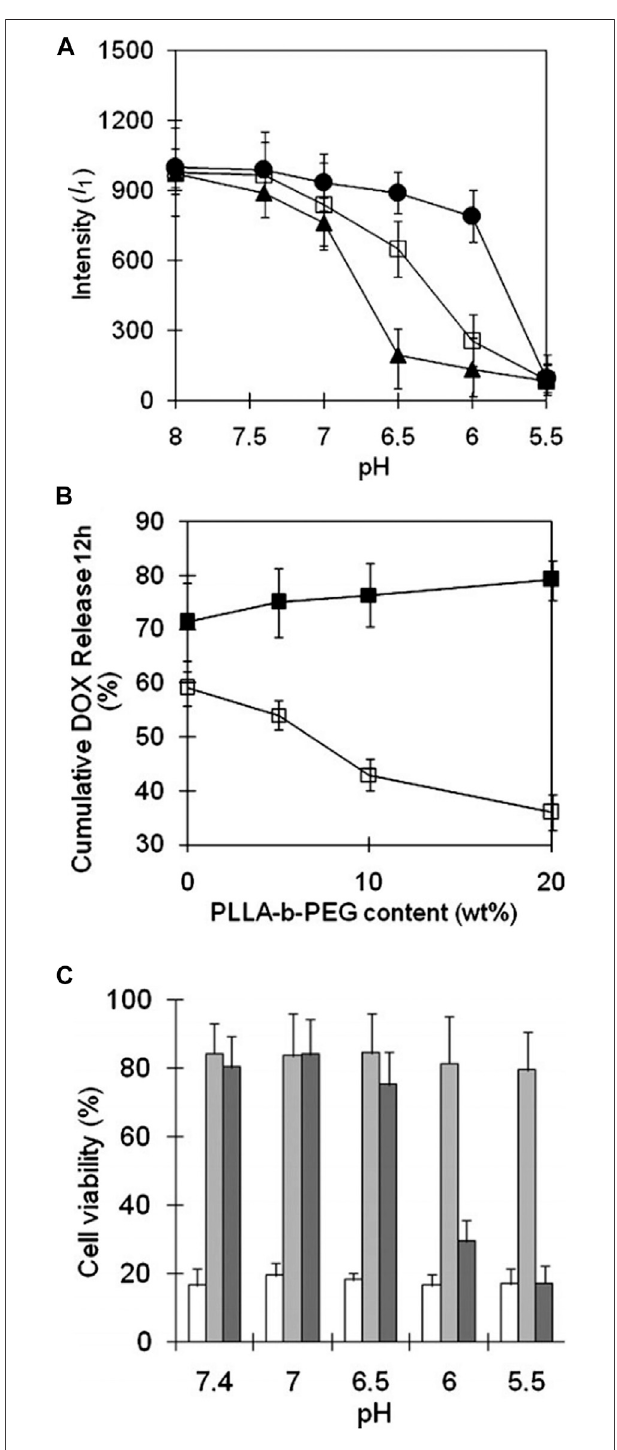
FIGURE13 |determinedbyMTTassayofovarianA2780wild-typecarcinoma cells treated with micelles: free DOX (white), DOX/PHIM (gray), and DOX/ m-PHSM(20%) (dark gray). DOX dose was equivalent to 1,000 ng ml − 1 in each formulation (Kim et al., 2008). Abbreviation: m-PHSM, pH-sensitive mixed micelles containing poly(histidine (His)-co-phenylalanine (Phe))-b- poly(ethylene glycol) (PEG) and poly(L-lactic acid) (PLLA)-b-PEG; PHIM, pH- insensitive PLLA-b-PEG